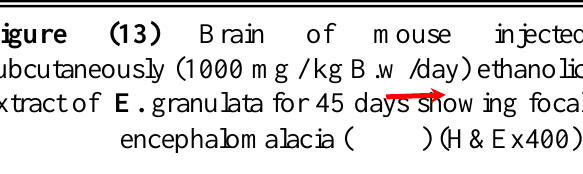
Figure (13) Brain of mouse injected Figure (14) Brain of mouse injected subcutaneously (1000 mg / kg B.w /day) ethanolic subcutaneously (1000 mg / kg B.w /day) ethanolic extract of E. granulata for 45 days showing focal extract of E. granulata for 45 days showing focal encephalomalacia ( ) (H&Ex400). aggregation of astrocytes ( ) (H&Ex400).